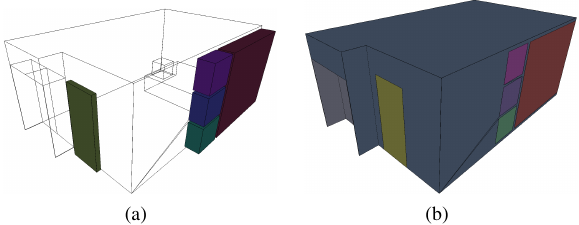
Figure 9: A 3 -cell of the FS-LCC with its surrounding openings. (a) 3 -cells of the openings. (b) Contact surfaces of the openings on the free space.